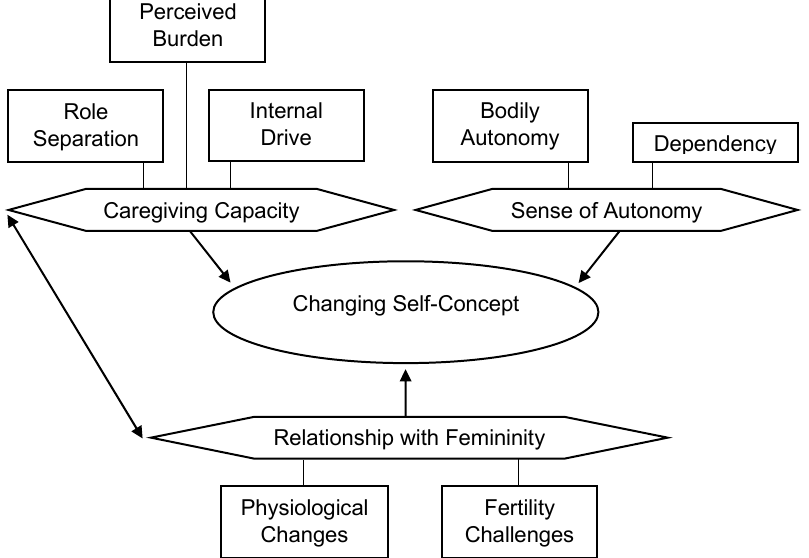
Figure 3. Visual map of Theme 2 by codes. Note. A line indicates that one component is a factor of another. One arrow indicates a unidirectional in fl uence, and two arrows indicate a bidirectional in fl uence.